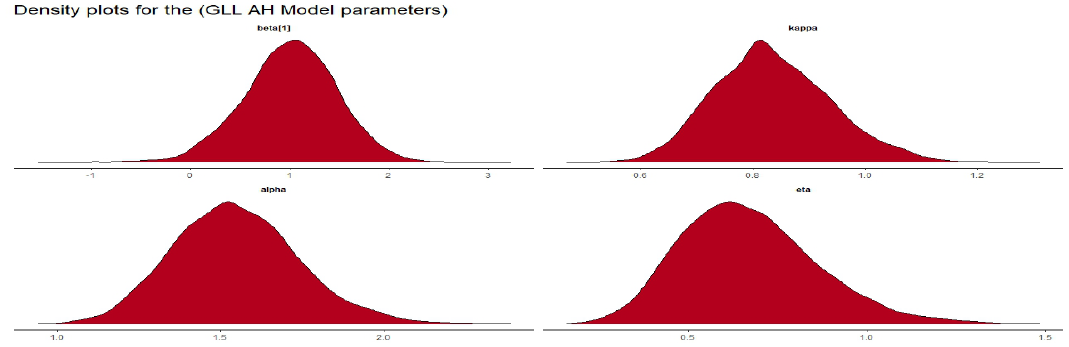
Figure 12. The GLL–AH model posterior parameters PDF plots of the gastric cancer data.